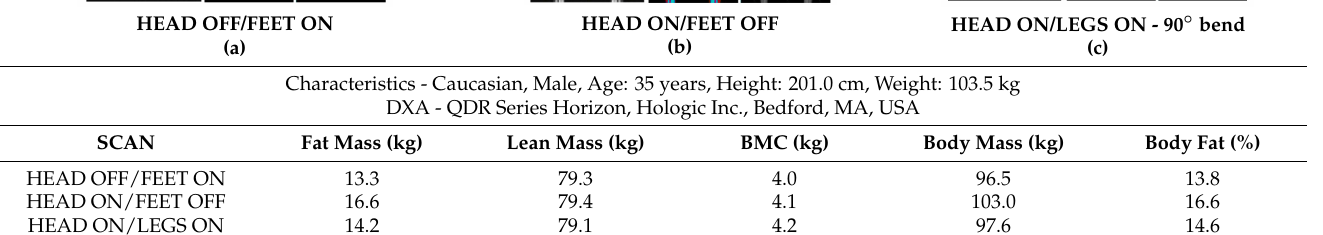
HEAD ON/LEGS ON - 90 ◦ bend